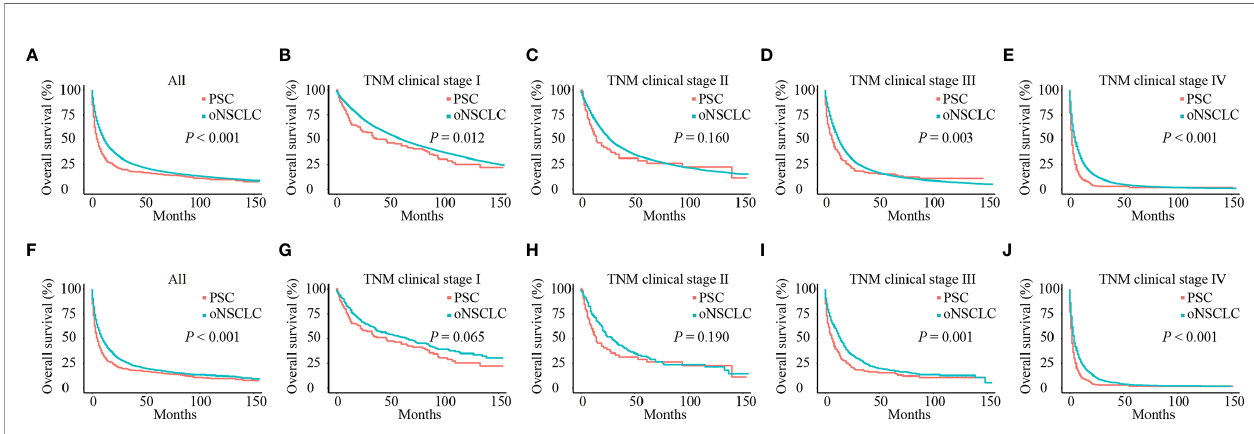
FIGURE 4 | Survival curves of patients with PSC and oNSCLC. (A) Before PSM, OS in patients with PSC and oNSCLC; (B – E) Before PSM, OS in patients with PSC and oNSCLC at different clinical stage; (F) After PSM, OS in patients with PSC and oNSCLC; (G – J) After PSM, OS in patients with PSC and oNSCLC at different clinical stage. PSC, pulmonary sarcomatoid carcinoma; oNSCLC, other non-small-cell lung cancer; PSM, propensity